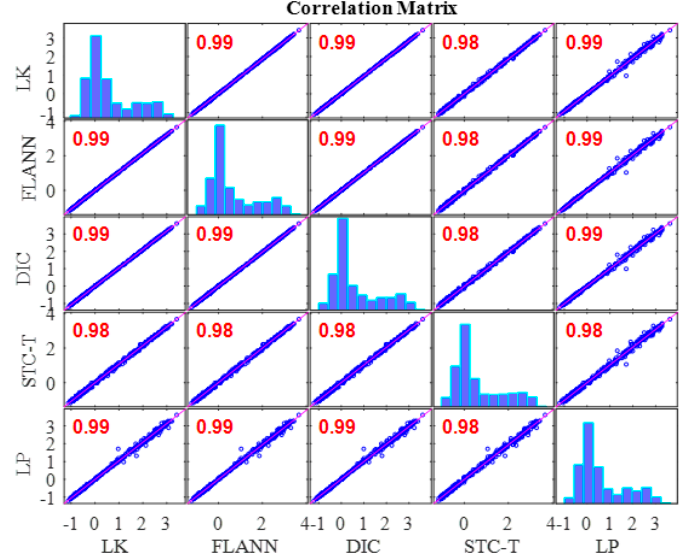
Figure 13. Correlation matrix of time displacement histories of Case 1 (ideal condition).